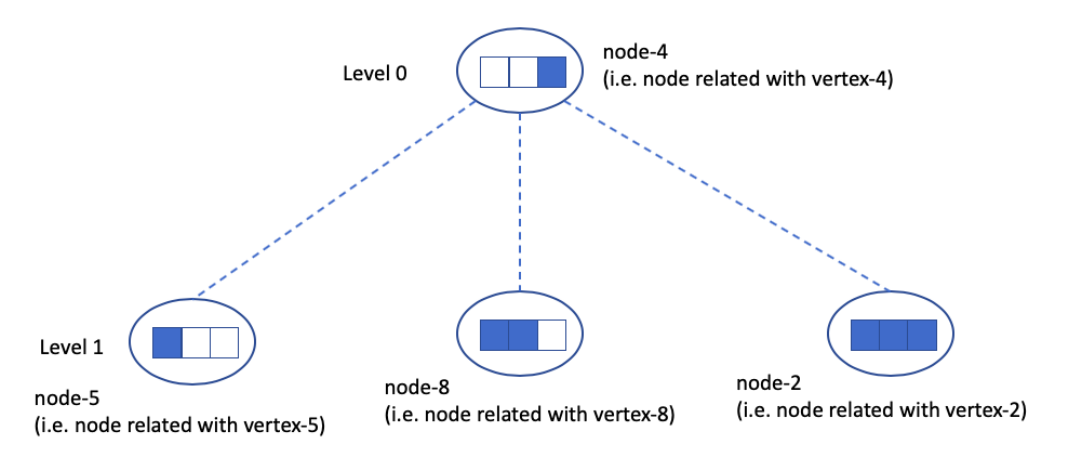
Figure 3. The internal vertices of Figure 1. Circles represent nodes and boxes in circles represent arrays cns [] . The filled box means true while the empty box means false. Currently, 6 coins have arrived at level-( h -1) (from level- h ): 1 for node-5, 2 for node-8, and 3 for node-2. In the root node, node-4, node-4. cns [ 3 ] = 1. This means that the third subtree of node-4 is fully filled with